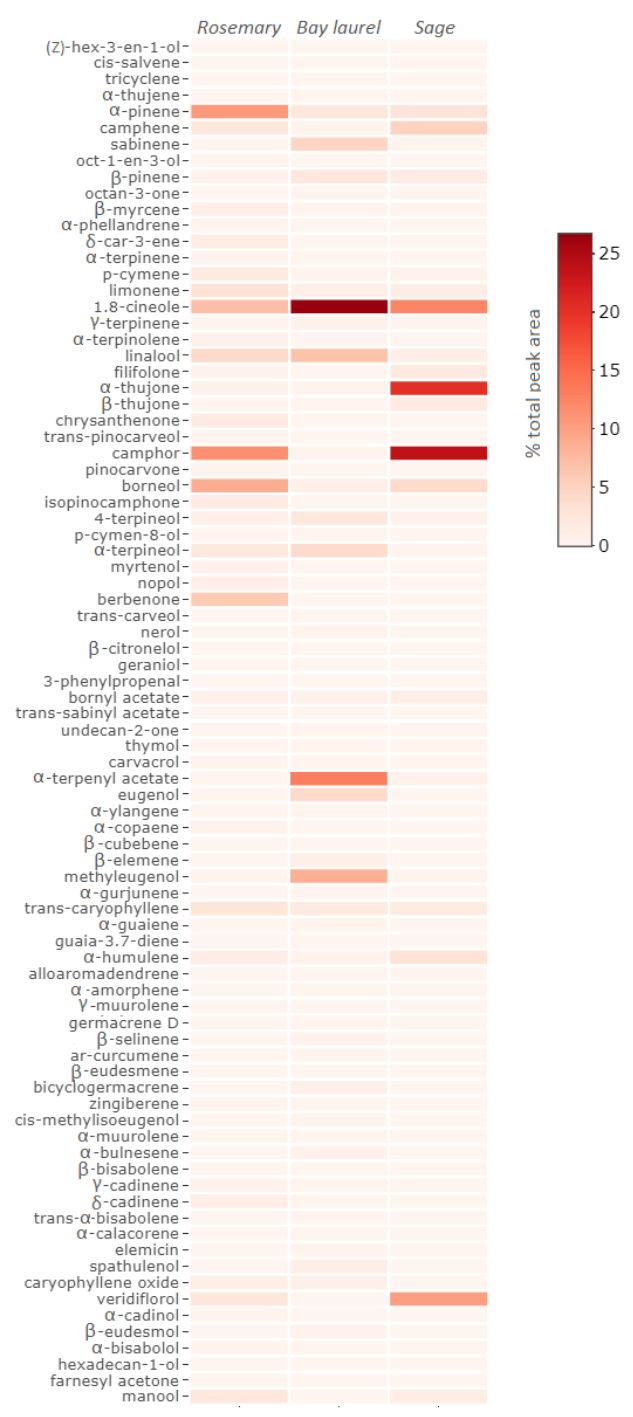
Figure 1. Heatmap of the volatile chemical composition of rosemary, bay laurel, and sage essential oils, as determined by Gas Chromatography–Mass Spectrometry (GC–MS).